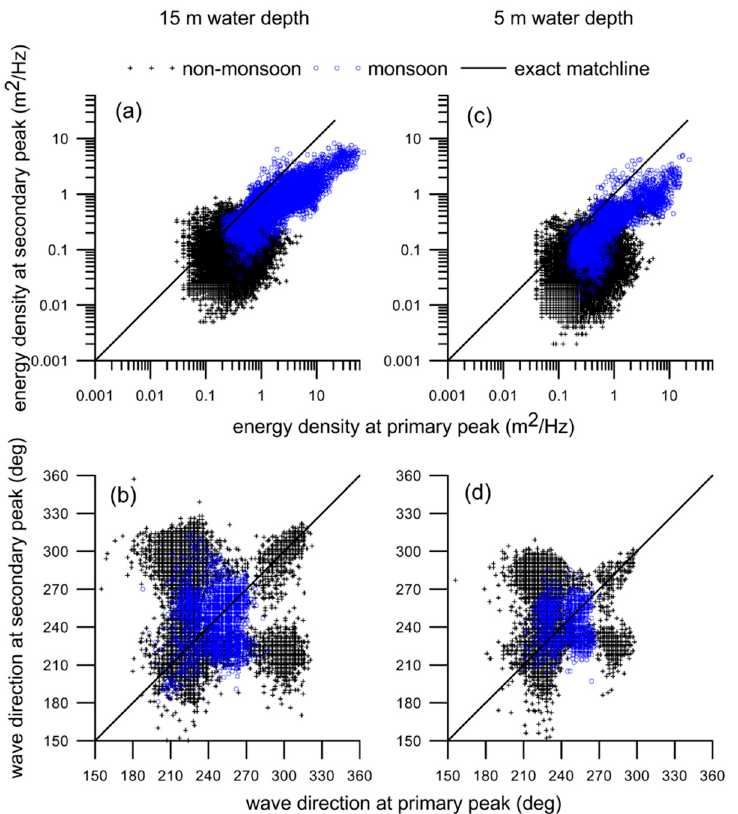
Figure 5. Top panel shows the scatter plot of spectral energy density at secondary peak with primary peak. Bottom panel shows the scatter plot of the wave direction at primary peak and secondary peak.